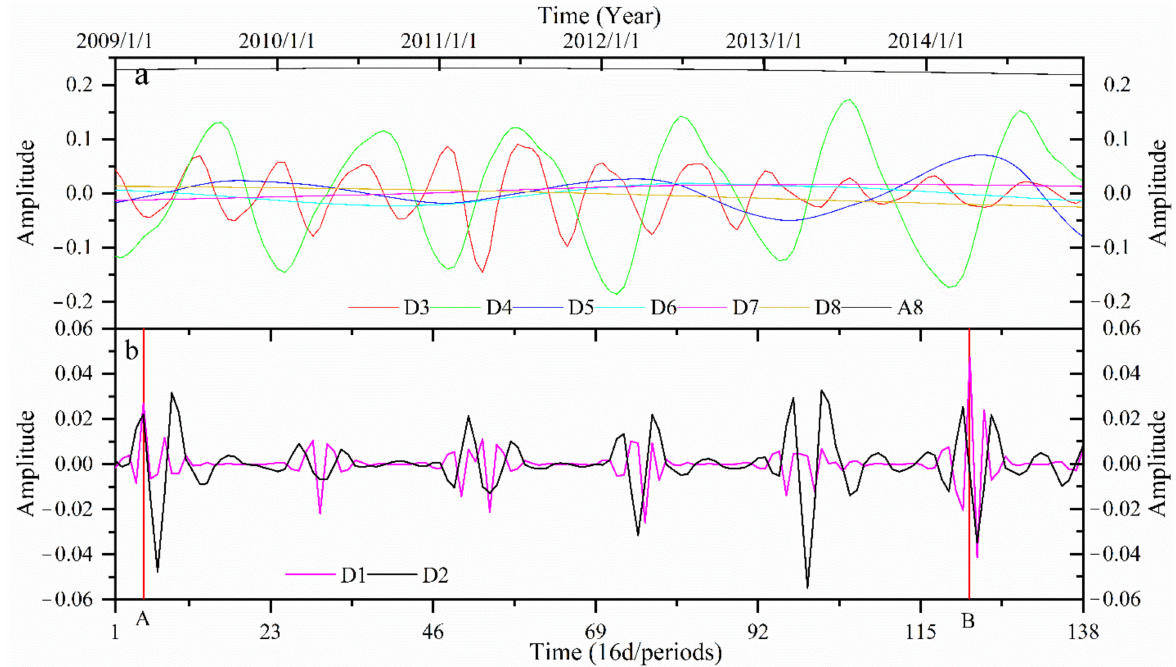
Figure 7. Results of wavelet decomposition of the blended NDVI time series: ( a ) D3 to D8 and A8 components and ( b ) D1 and D2 components. Reference lines A and, B are in early March 2009 and early April 2014